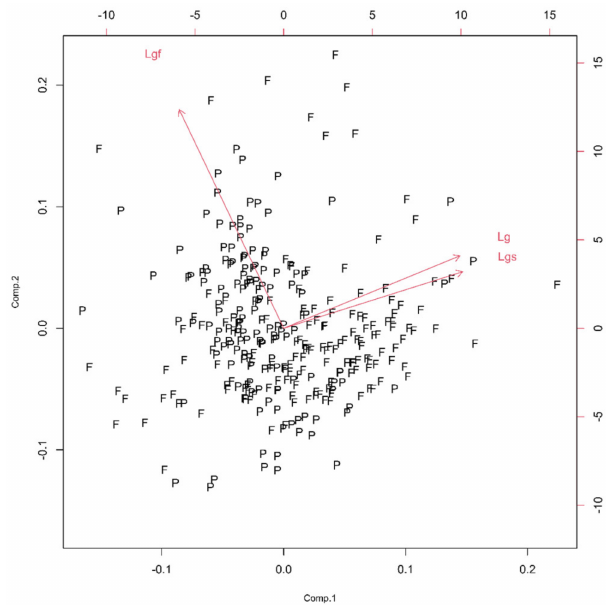
Figure 9. The PCA-based bi-plots of parameters characterizing morphological features in the given parameter space. Relationships between first two standardized principal components of the homo- geneity. A careful reader should have in mind that the notation in the given graph in this group consists of Lgf , Lg and Lgs , and in the text, of corresponding Lgf , Lg and Ls ,